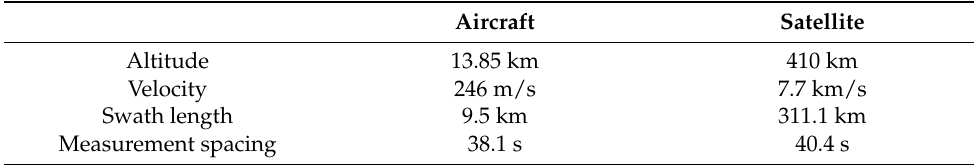
Table 4. Characteristics of aircraft vs. satellite CMIS